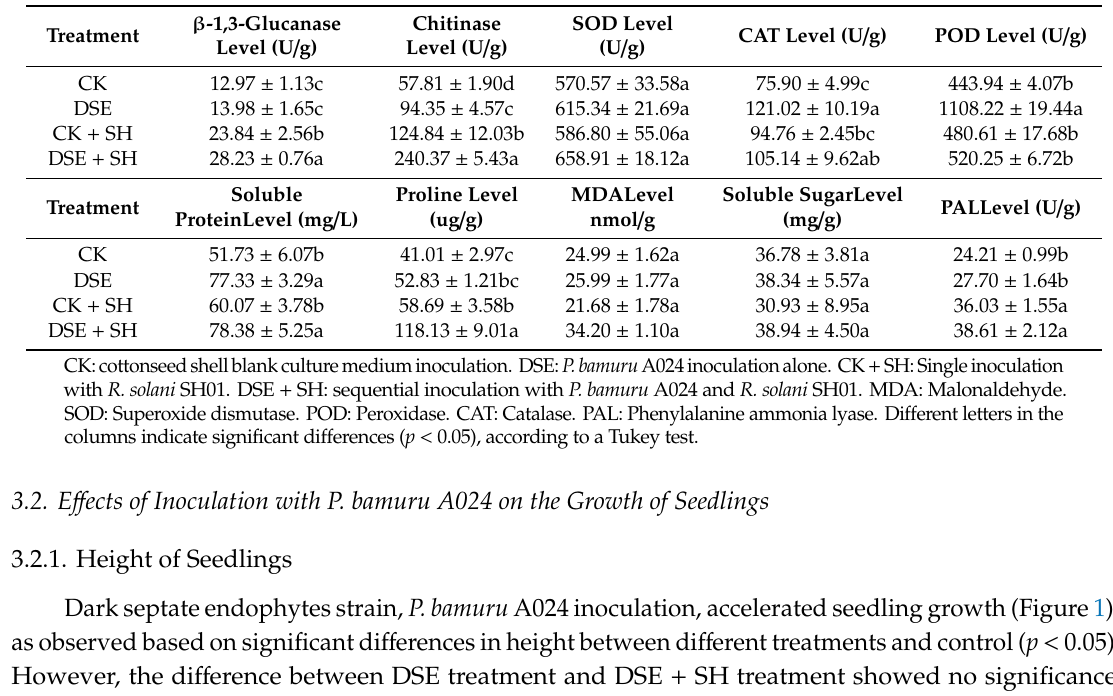
Table 1. E ff ects of di ff erent inoculation treatments on seedling physiological indices.